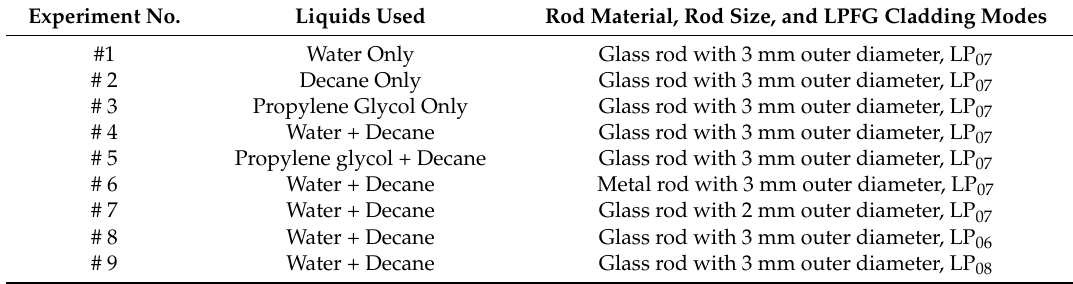
Table 1. Laboratory Test